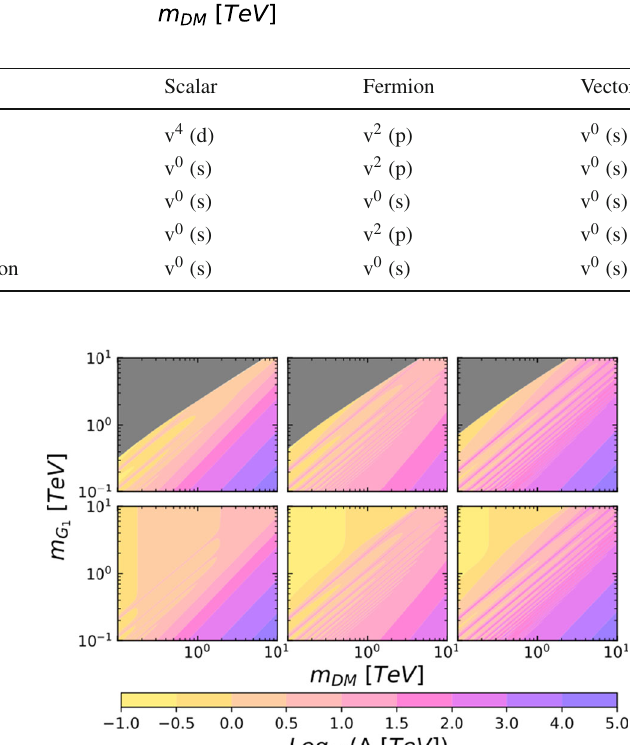
to the thermally-averaged annihilation cross-section. The three panels represent (from left to right): scalar, spin 1/2 fermion and vector boson DM particles. In all cases we consider m r = 100 GeV, = 1 TeV and (cid:3) = 10 TeV m G 1